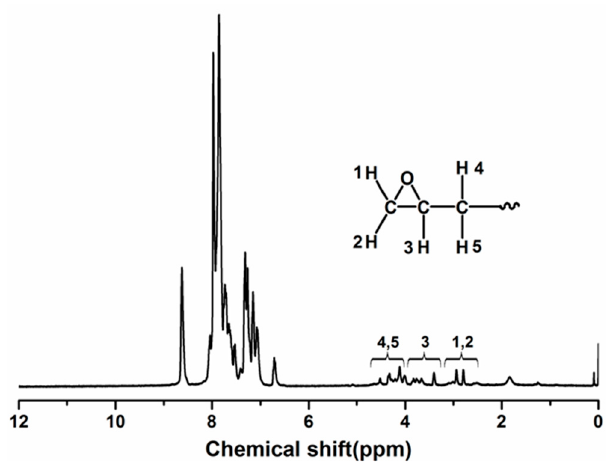
Figure 2. 1 H nuclear magnetic resonance (NMR) spectrum of polymer E-PPENSK terminated with epoxy group. Table 1. Solubilityof the polymers in various solvents a .